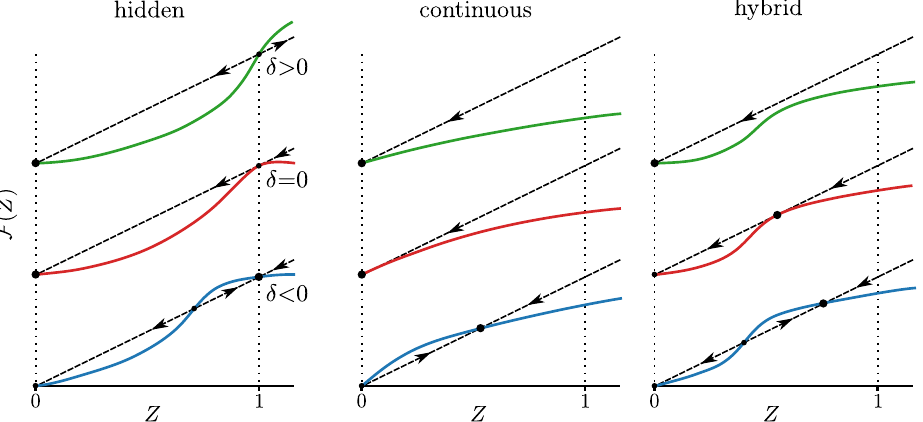
3 layers, (leftmost panel). From top to bottom the Figure 2. Qualitative behavior of the function F ( Z ) in m ≥ function is shown above (collapse), at, and below (stable) the point of the hidden transition, respectively. The Z , indicated by the dashed line, i.e. when the value fixed points occur when the curve crosses the line F ( Z ) = of the function equals Z . The stability of the fixed points is indicated by the arrows. An undamaged multiplex 1 above, at, and below the transition point, but any network with a hidden transition stays in the state Z = 0 ). For comparison, we illustrate 0 at and below the transition ( δ damage results in the final state Z ≥ = the behavior of the corresponding function for the usual hybrid transition (middle panel) and a continuous transition (right